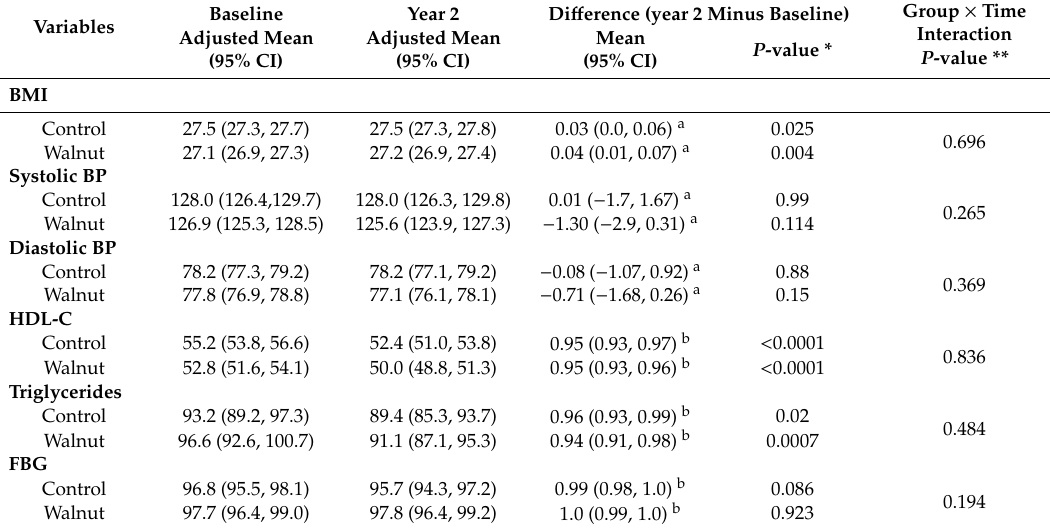
Table 3. The e ff ect of walnut consumption on the di ff erence (year 2 minus baseline) of each component of metabolic syndrome (MetS).